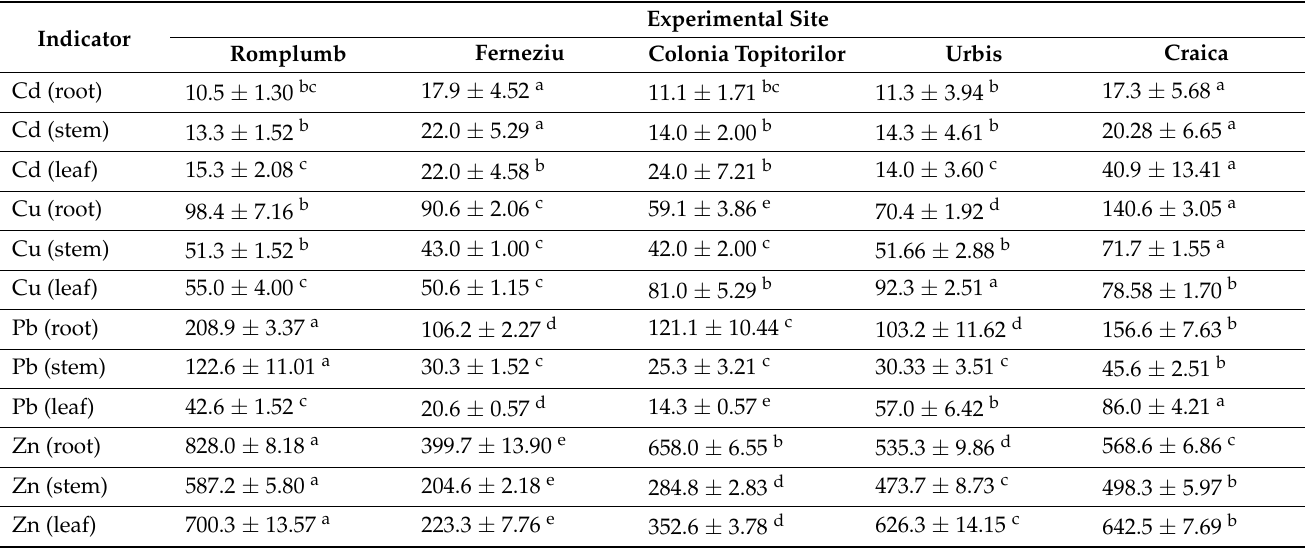
Table 3. Variation in heavy metal content (Cd, Cu, Pb and Zn; mg kg − 1 ) in Reynoutria japonica Houtt. plant tissues among the studied experimental